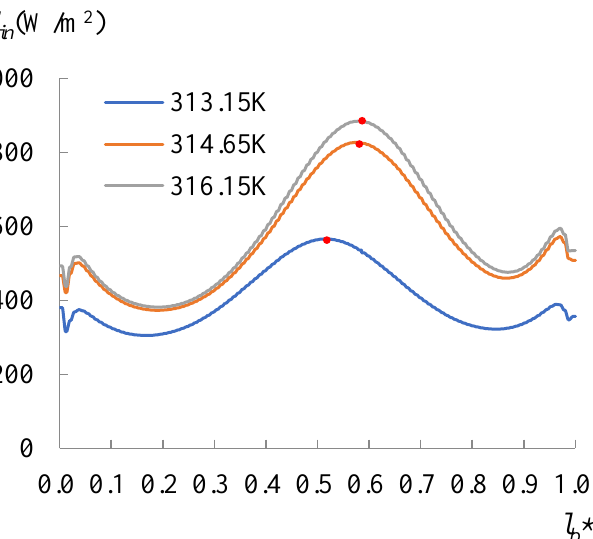
Figure 14. The heat flux conducted from the substrate for T s = 313.15 to 316.15 K. The higher heat flux (dividing points) moved rightward with the increasing heating temperature.